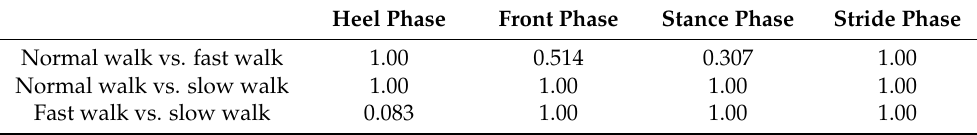
Table A4. Significance of post hoc tests for power measured for different gait rates.